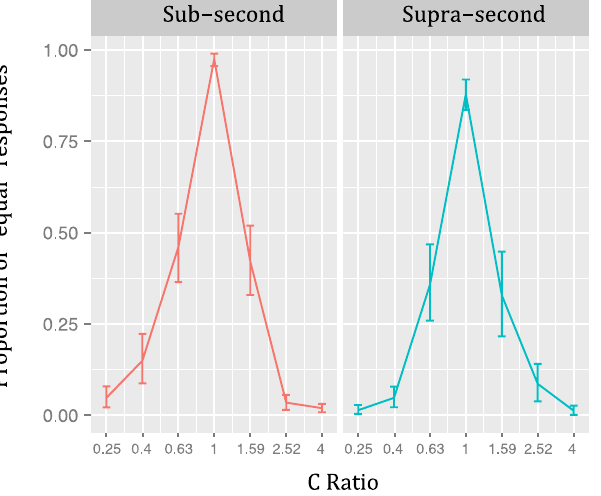
Figure 7. Temporal generalization gradients of Experiment 3 (logarithmically spaced ratios). Proportion of “equal” responses as a function of the ratio of the comparison duration when collapsing presentation orders Vertical lines represent 95% confidence levels.